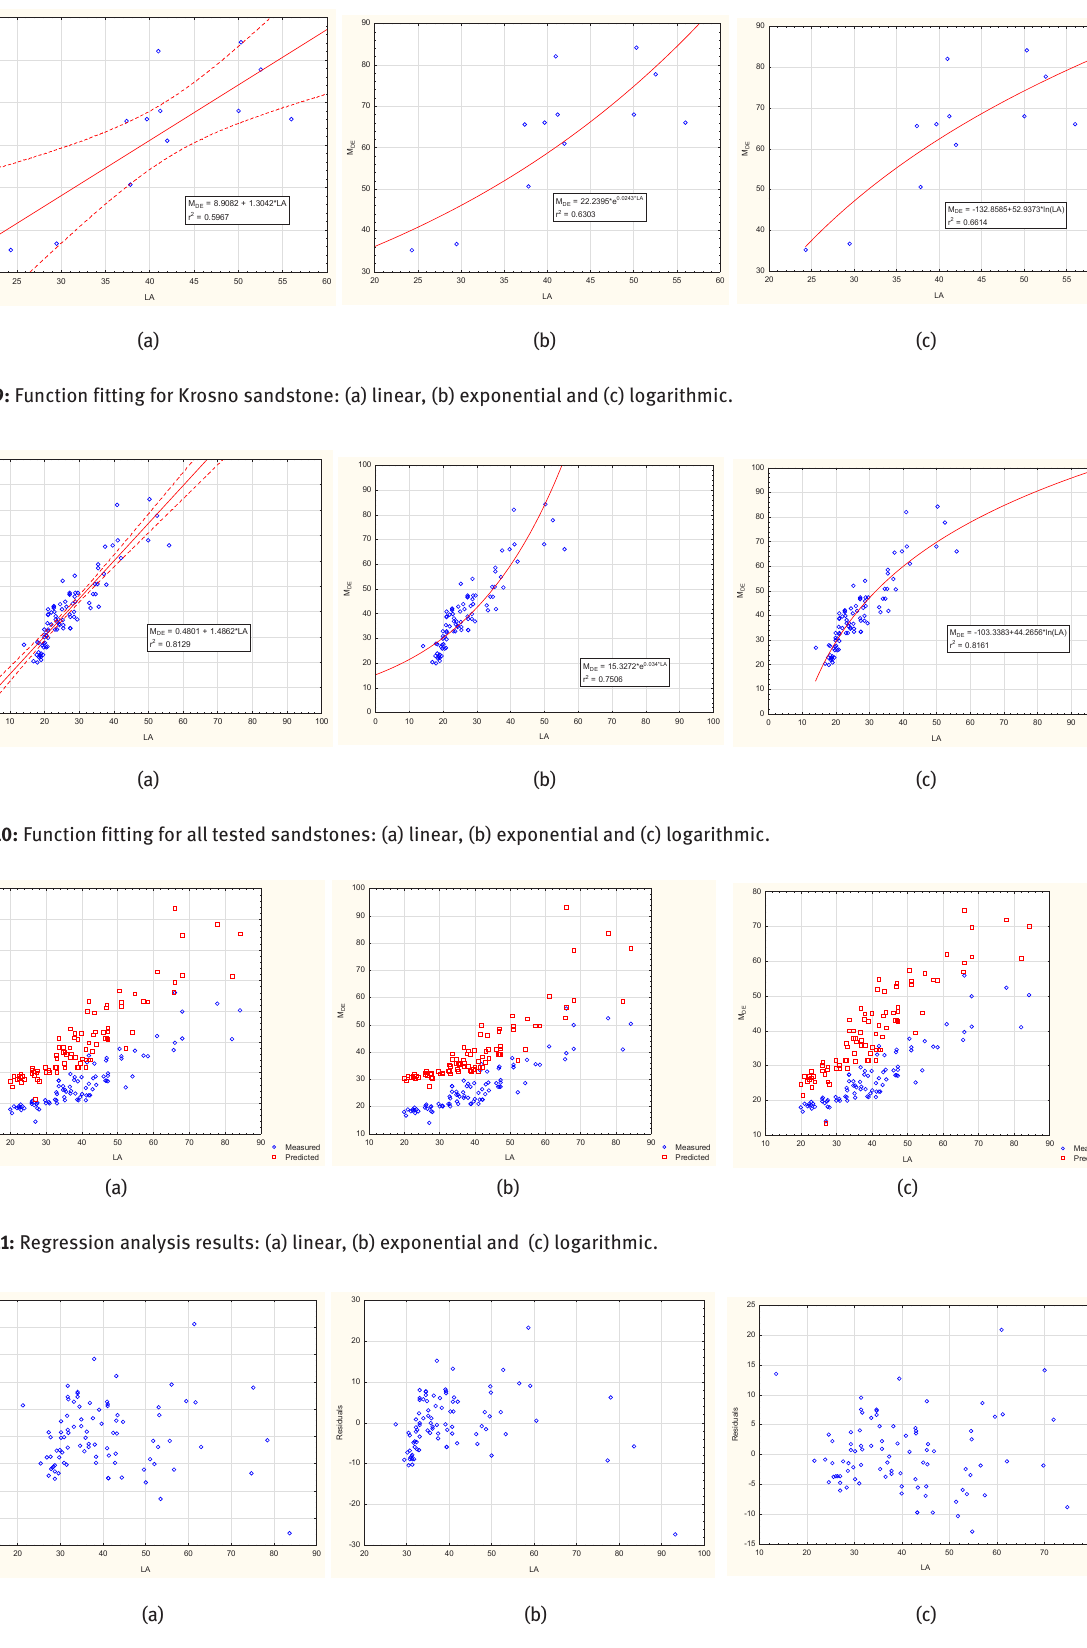
Figure 12: Residuals for all tested sandstones: (a) linear, (b) exponential and (c) Fig. 11. Regression analysis results: (a) linear, (b) exponential and (c) logarithmic